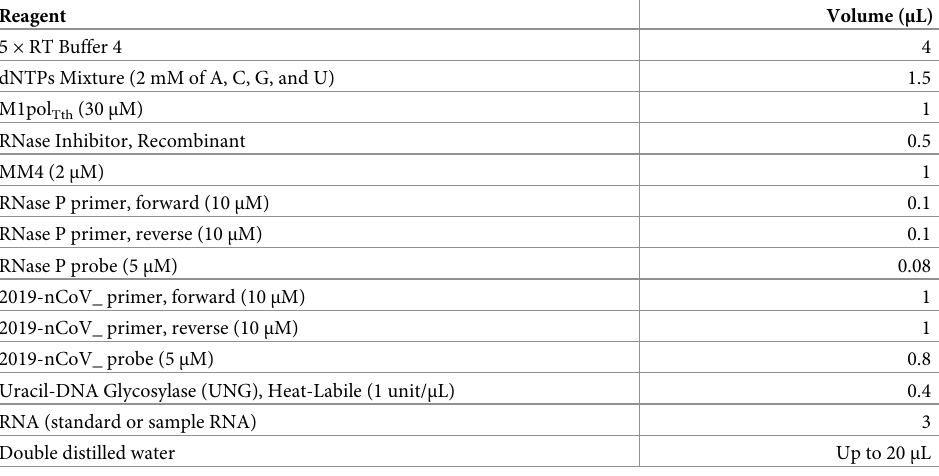
Table 5. Optimized RT-PCR conditions for SARS-CoV-2 detection with the MoCO kit.